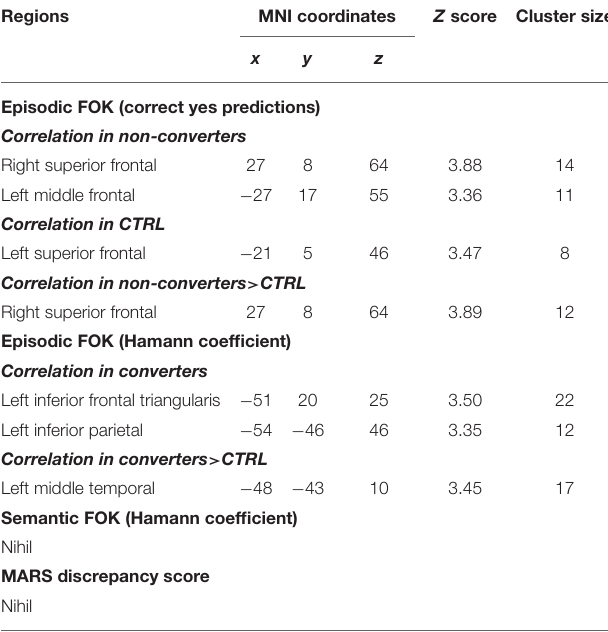
TABLE 4 | SPM results: Significant correlations between regional metabolism and self-awareness measures (small volume correction, p < 0.05 FWE-corrected for multiple comparisons).